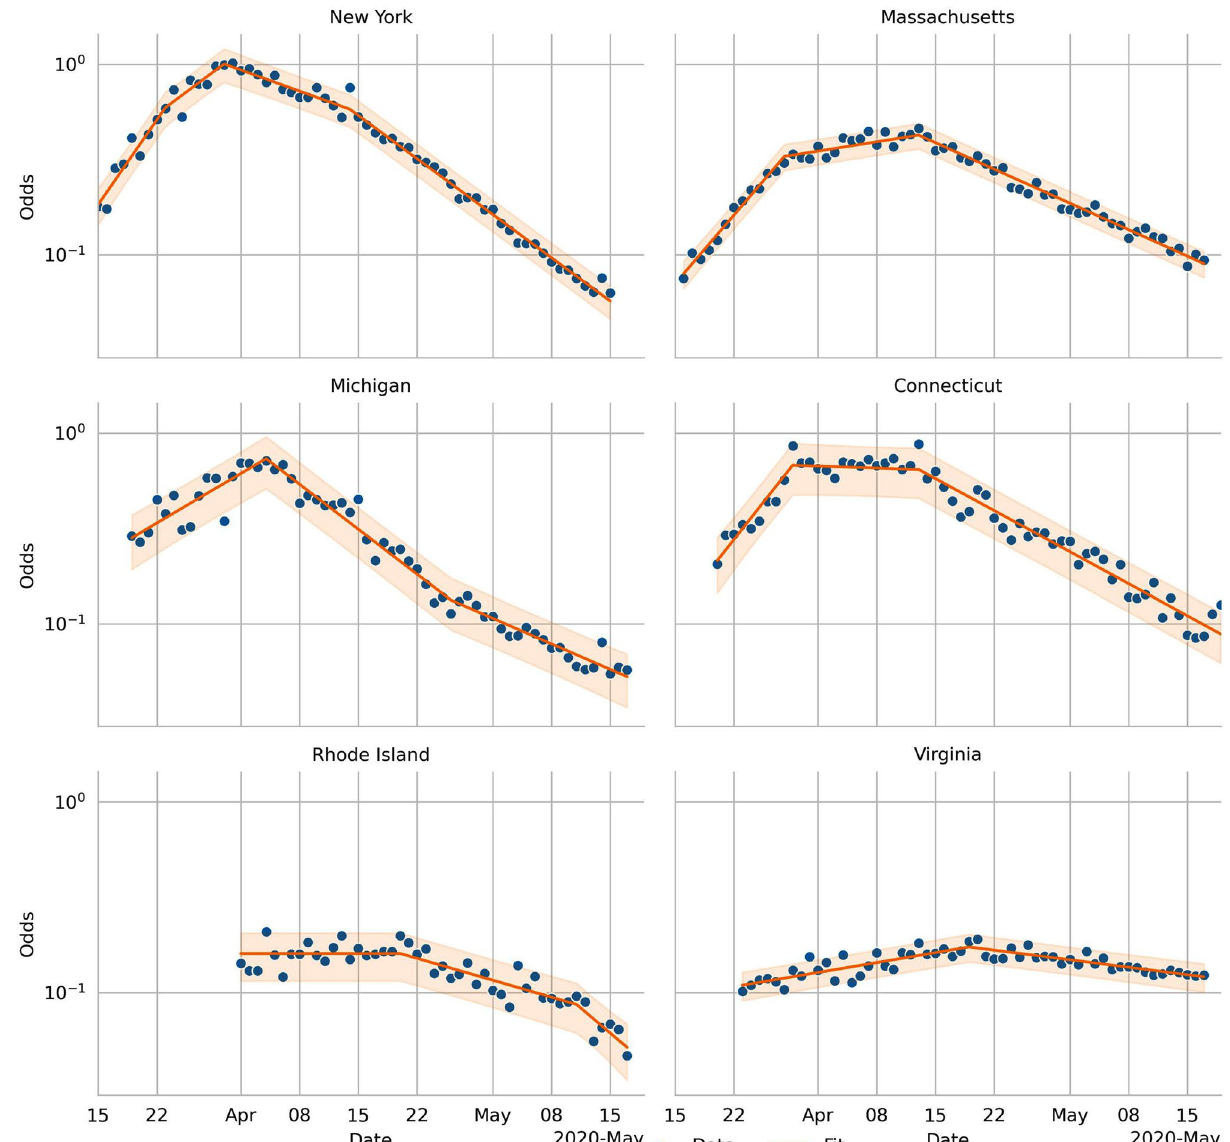
Figure 2. The odds of a positive test in logarithmic scale. Under the assumptions of the model, this variable should be piece-wise linear. The blue dots are the data points. The orange lines regressed model and the orange shades are is the 95%